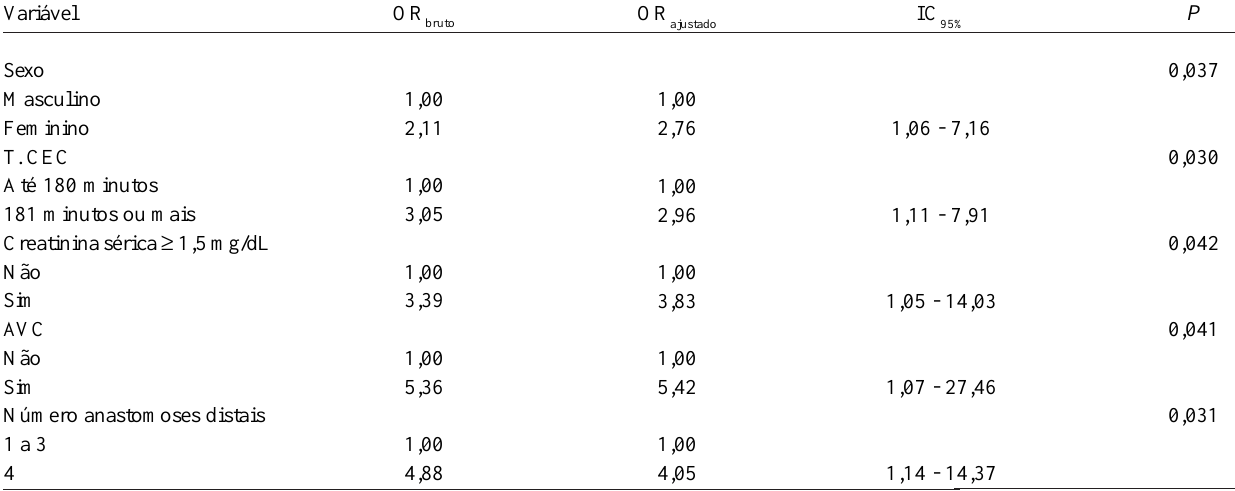
G2: portadores de EAo, associada à DAC crítica, submetidos à SVA combinada à RM. G2A: portadores de EAo, associada à DAC crítica, submetidos à SVA combinada à RM completa. G2B: portadores de EAo, associada à DAC crítica, submetidos à SVA combinada à RM incompleta. N. o : número. OR: odds ratio (medida de associação). IC : intervalo de confiança com nível de confiança de 95% de cada 95%